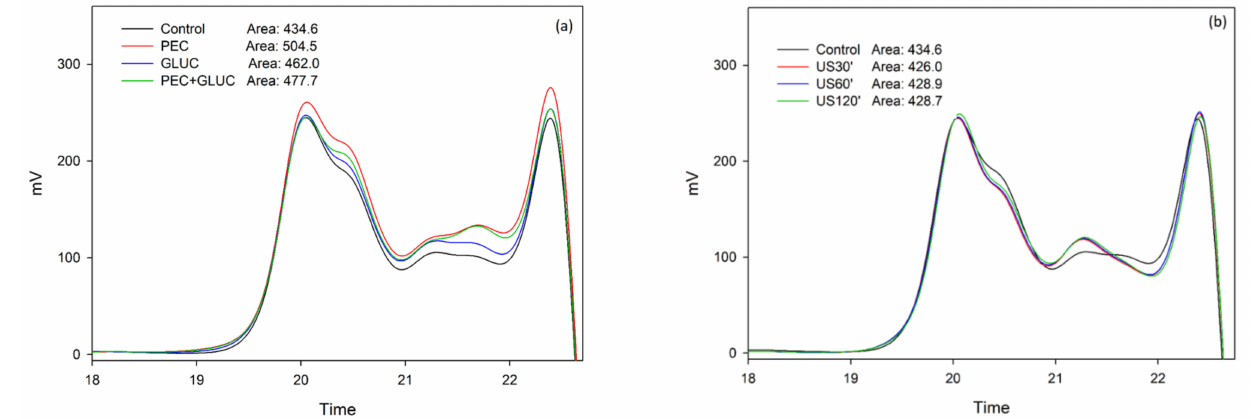
Figure 3. Mass distribution of the polysaccharides released from lees analyzed by SEC in the elution time comprised between 12 and 20 min. ( a ) Comparison of polysaccharides composition released with the enzyme treatments. ( b ) Comparison of polysaccharides composition released with the US treatments. This figure was made in SigmaPlot 10.0.